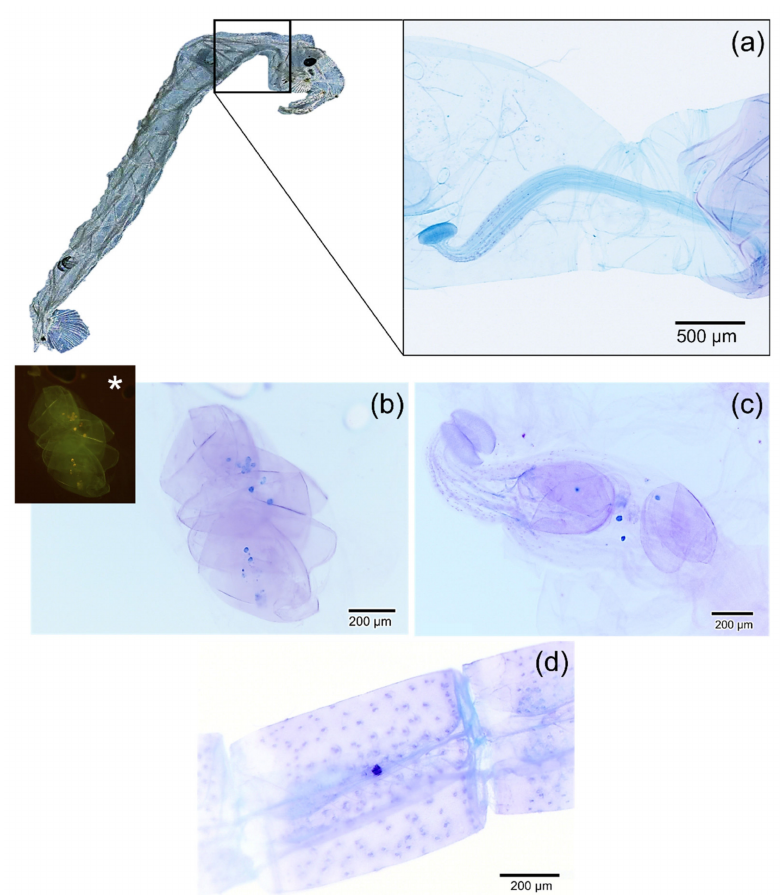
Figure 3. Habitus of Chaoborus larva with enhanced image of empty crop ( a ). Fluorescence micro- scopic images of PA particles (blue) in the crops of Chaoborus sp. larvae with zooplankton shells after exposure to 150 mg L − 1 PA ( b , c ) and PA particles in the intestine of Chaoborus sp. imago after exposure to 150 mg L − 1 PA ( d ). Colors are inverted (asterisk shows original